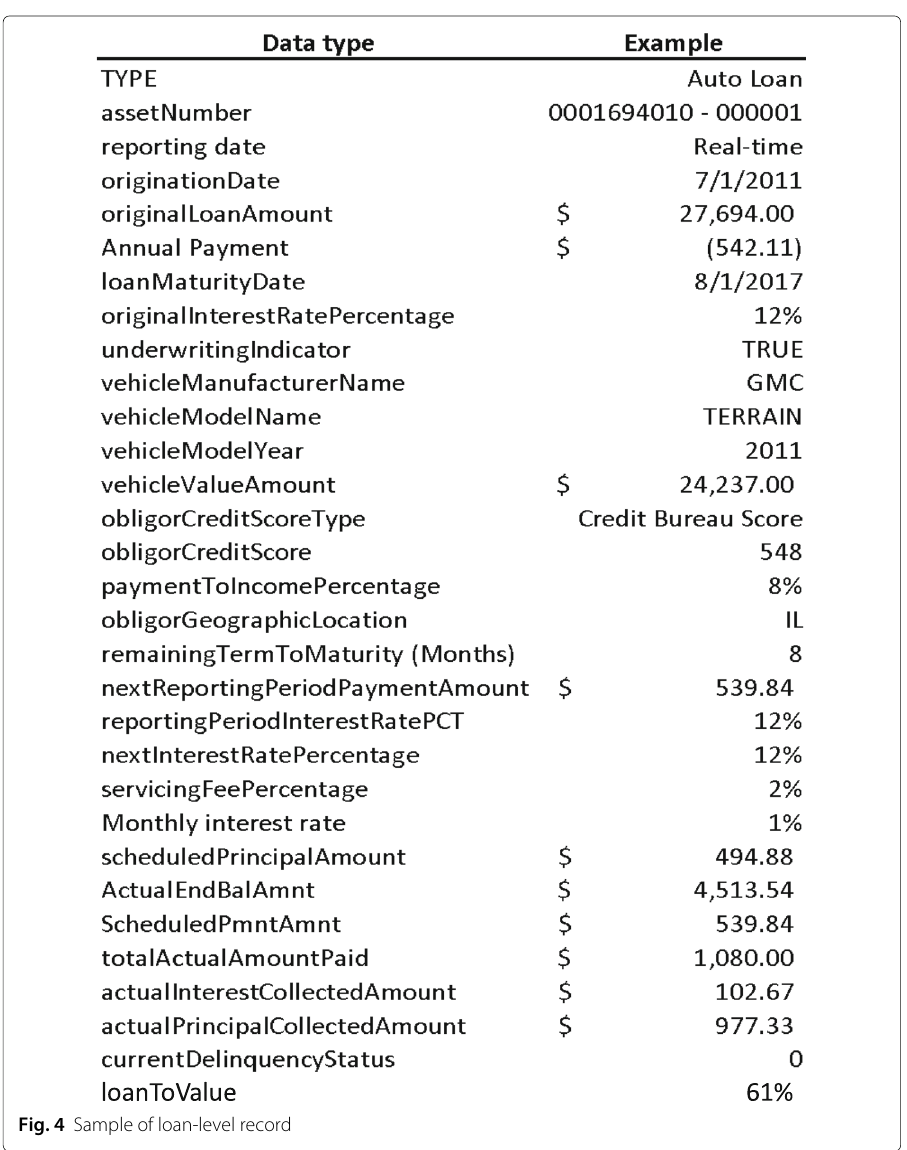
Fig. 4 Sample of loan-level record